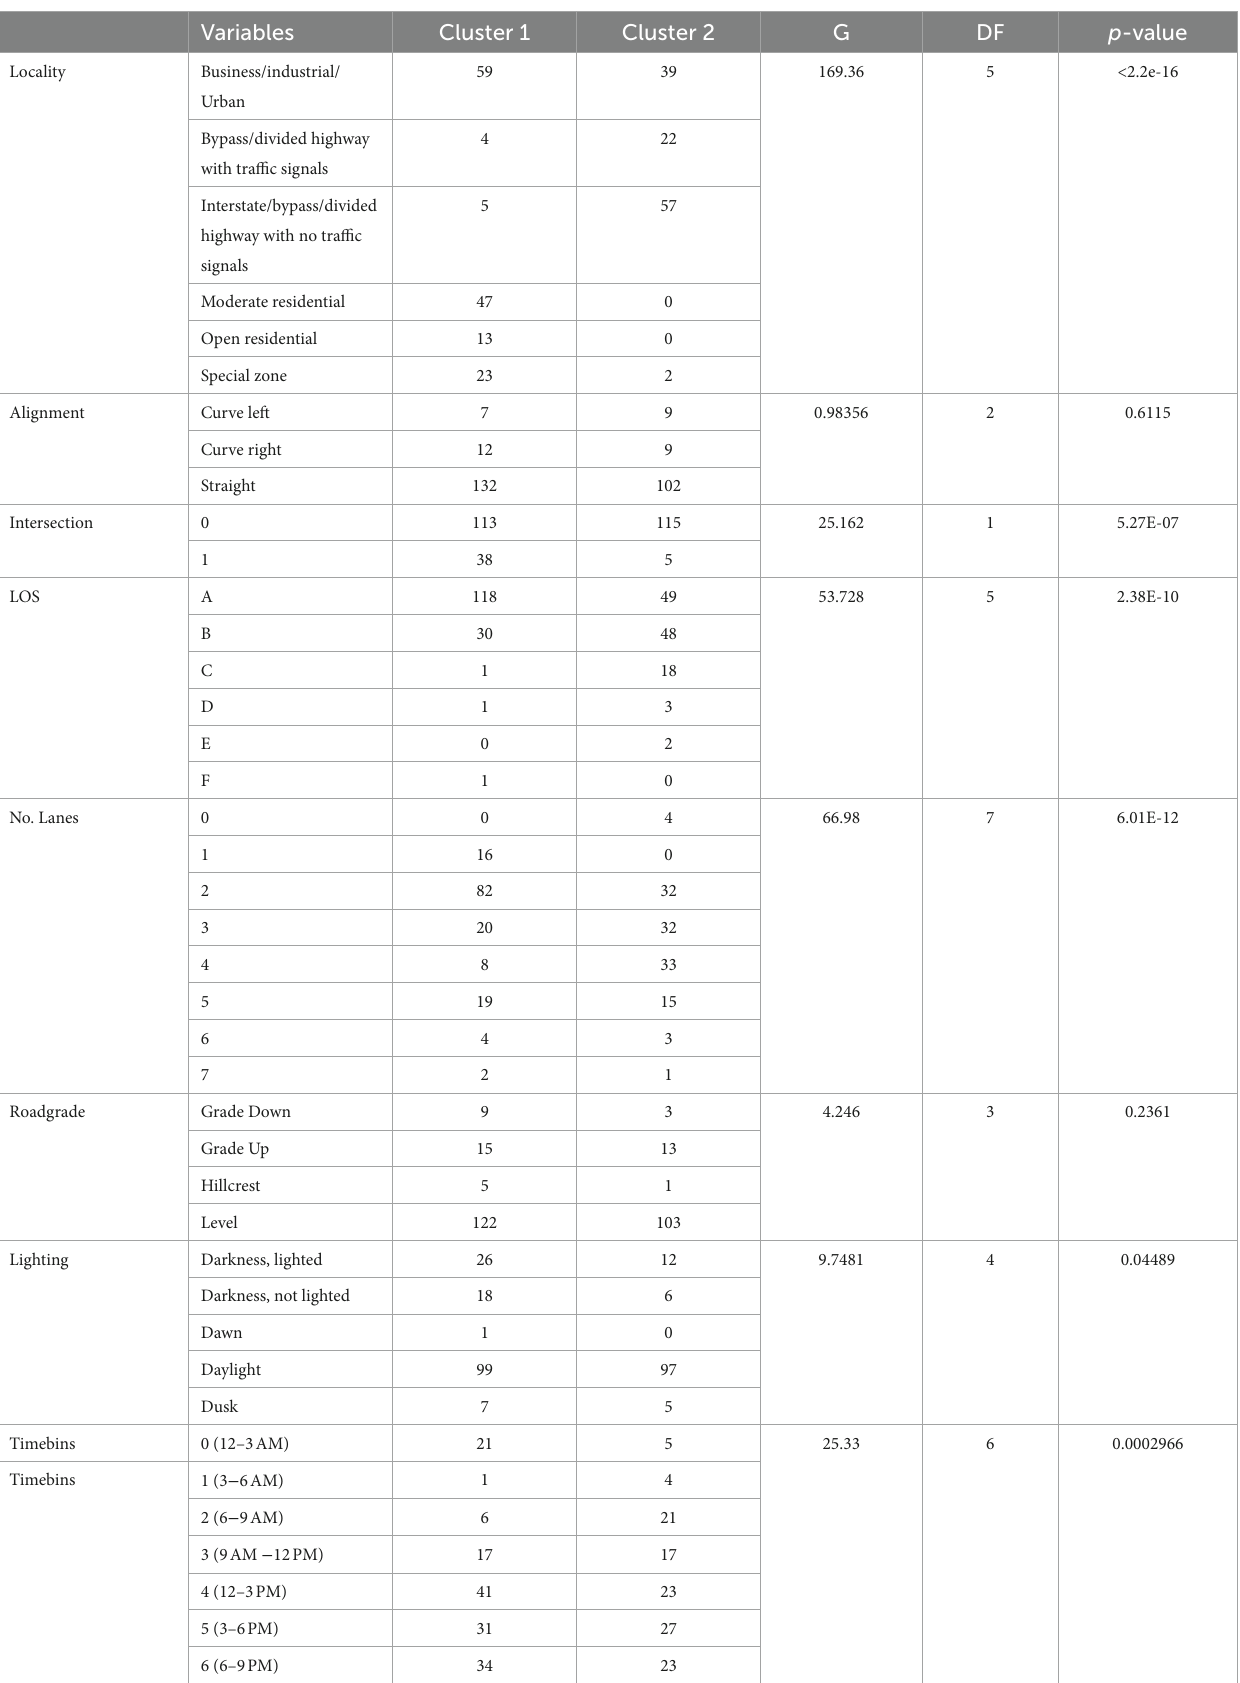
TABLE 4 Context variables between-cluster